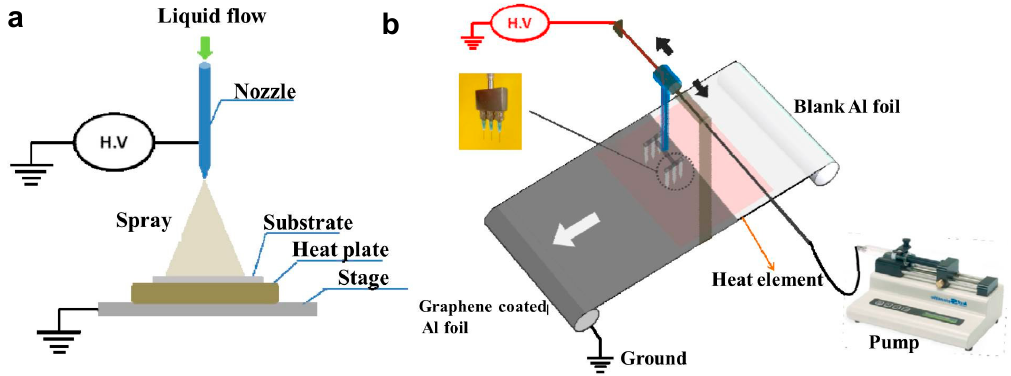
Figure 2. Schematic plot of ( a ) electron-spray deposition and ( b ) roll-to-roll device with a pump. Reproduced from [40] with permission; Copyright 2014 Wiley Online Library.